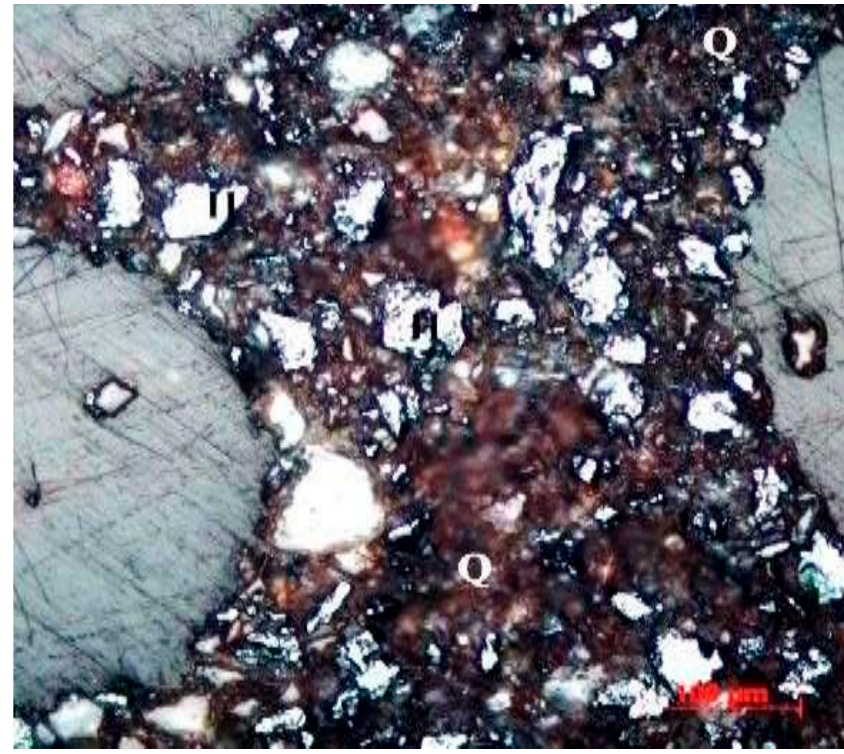
Figure 3. Dispersions of fine-grained hematite with quartz (×250).